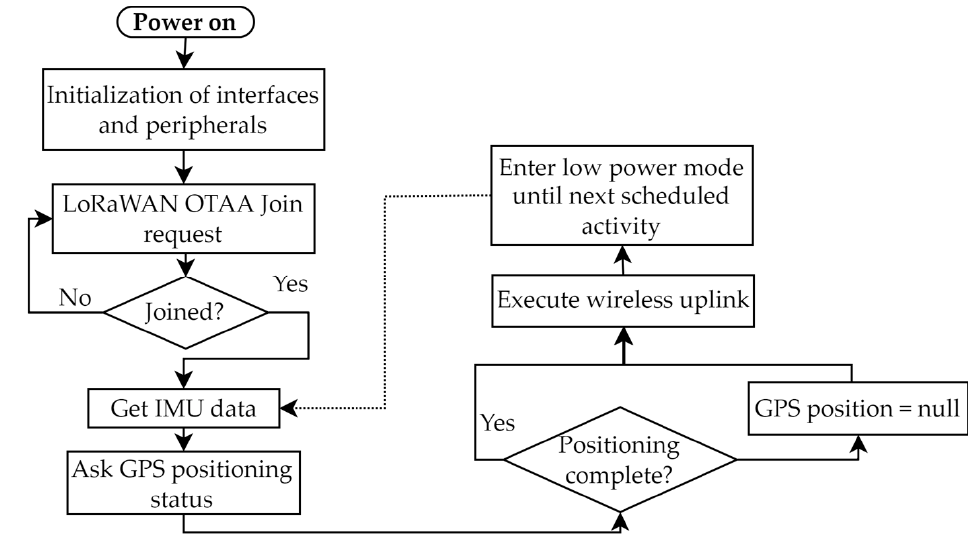
Figure 8. Worker tracking node operation flow diagram in normal mode.